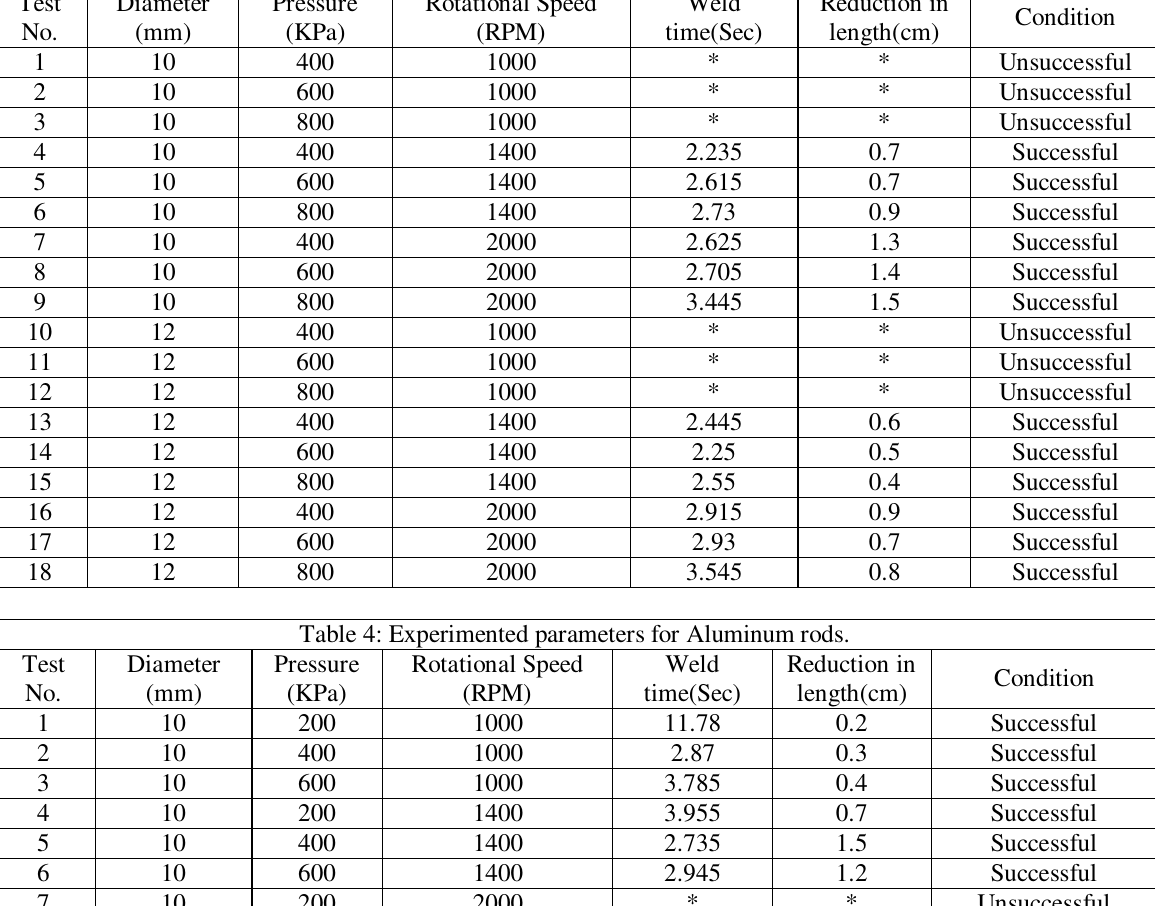
Table 3: Experimented parameters for Steel rods